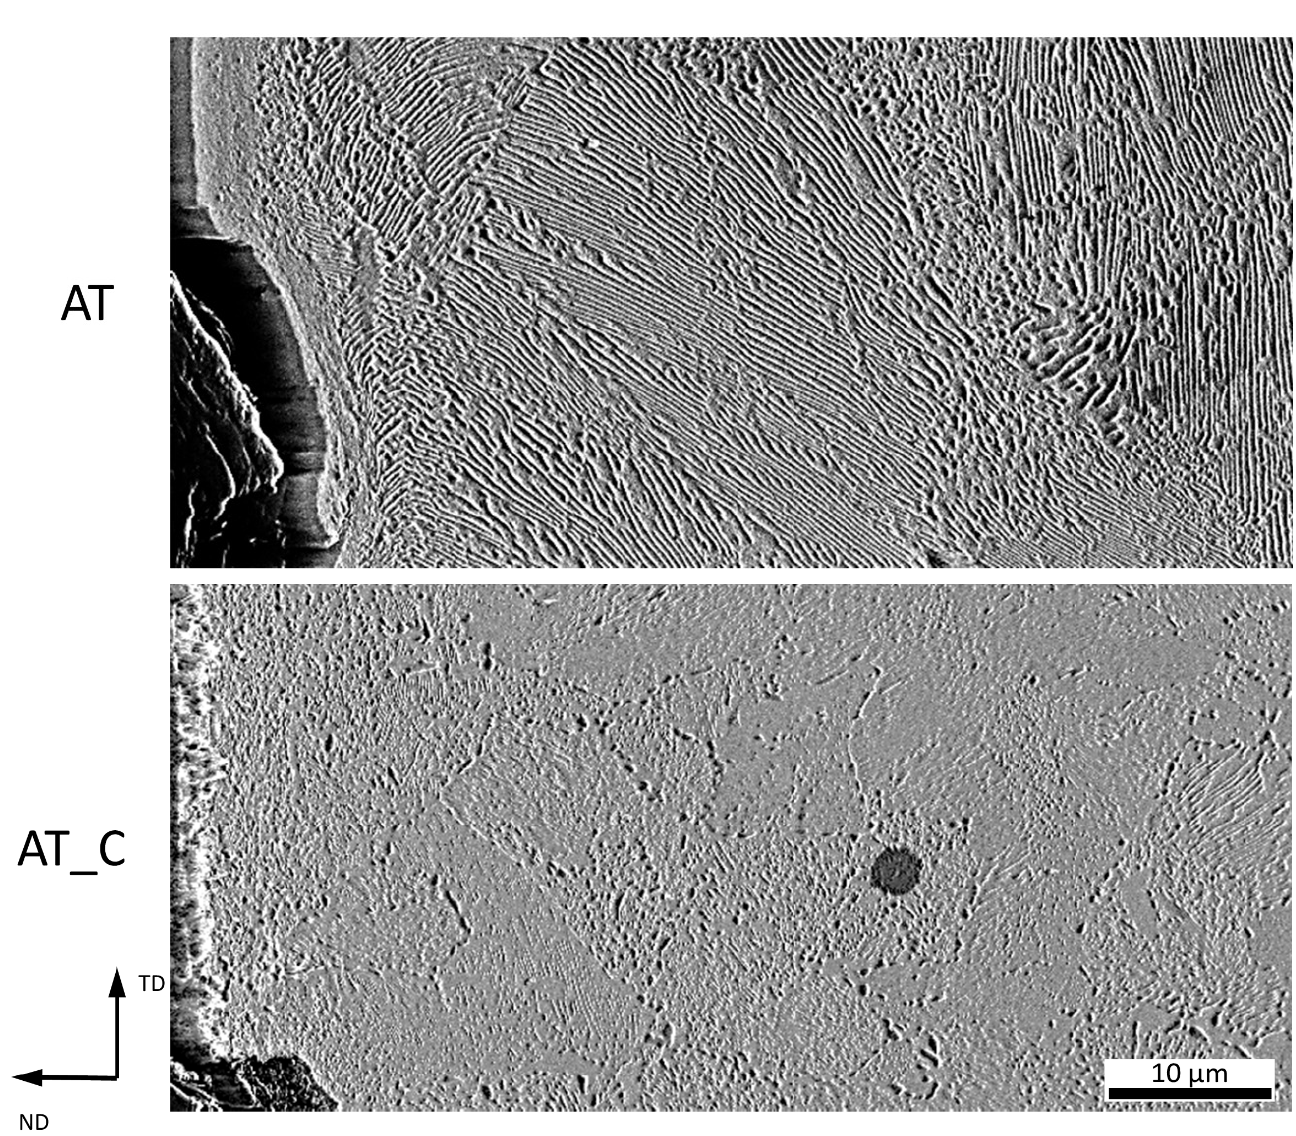
Figure A1. SEM images for the non-deformed state (T0) for Ring AT and Ring AT_C. The measure- ments were performed along the transverse direction.